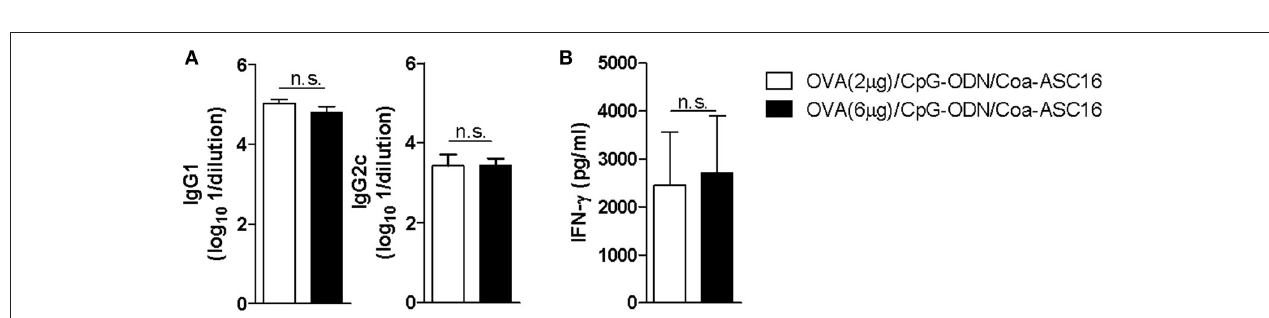
FIGURE 3 | The nanostructured formulation allows antigen dose-sparing without compromise the resulting antigen-specific immune response. C57BL/6 mice were immunized on day 0, 7, and 14 with OVA (2 µ g)/CpG-ODN/Coa-ASC16 or OVA (6 µ g)/CpG-ODN/Coa-ASC16. Seven days after the last immunization, plasma and spleen were obtained. (A) Titers of OVA-specific IgG1 and IgG2c in plasma determined by ELISA. (B) Ex vivo IFN- γ secretion by splenocytes after stimulation with OVA determined by ELISA. The data show the mean ± SEM of individual values (4 mice/treatment group in each experiment) and are representative of two independent experiments performed. n.s., not